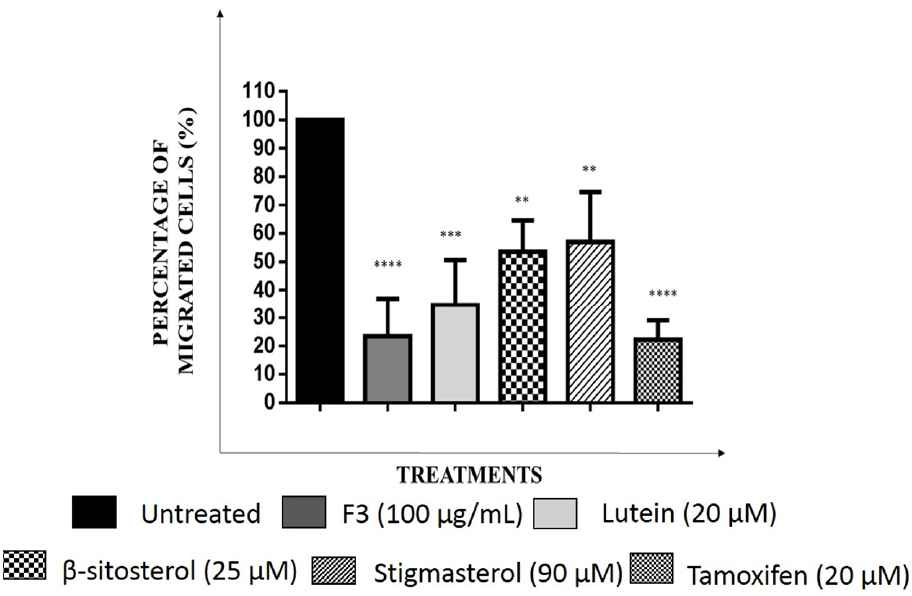
Figure 9. The percentage of migrated MDA-MB-231 cells, treated with IC 50 concentrations of F3, lutein, β -sitosterol, and stigmasterol for 24 h, compared to control (untreated). Data are presented as the mean ± SD ( n = 3). ** p < 0.01; *** p < 0.001; **** p < 0.0001.